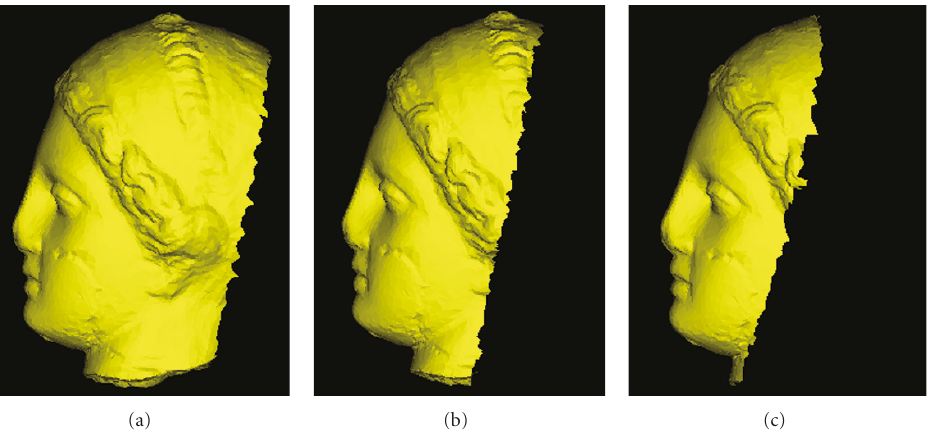
Figure 6: (a) 30% (b) 50% (c) 70% faces cropped from the watermarked 3D model and 0.3%